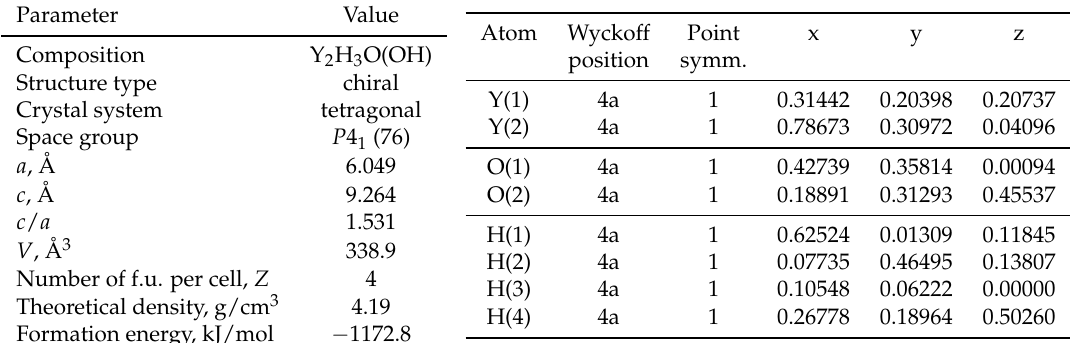
Table 1. Equilibrium crystal data predicted for Y 2 H 3 O(OH).